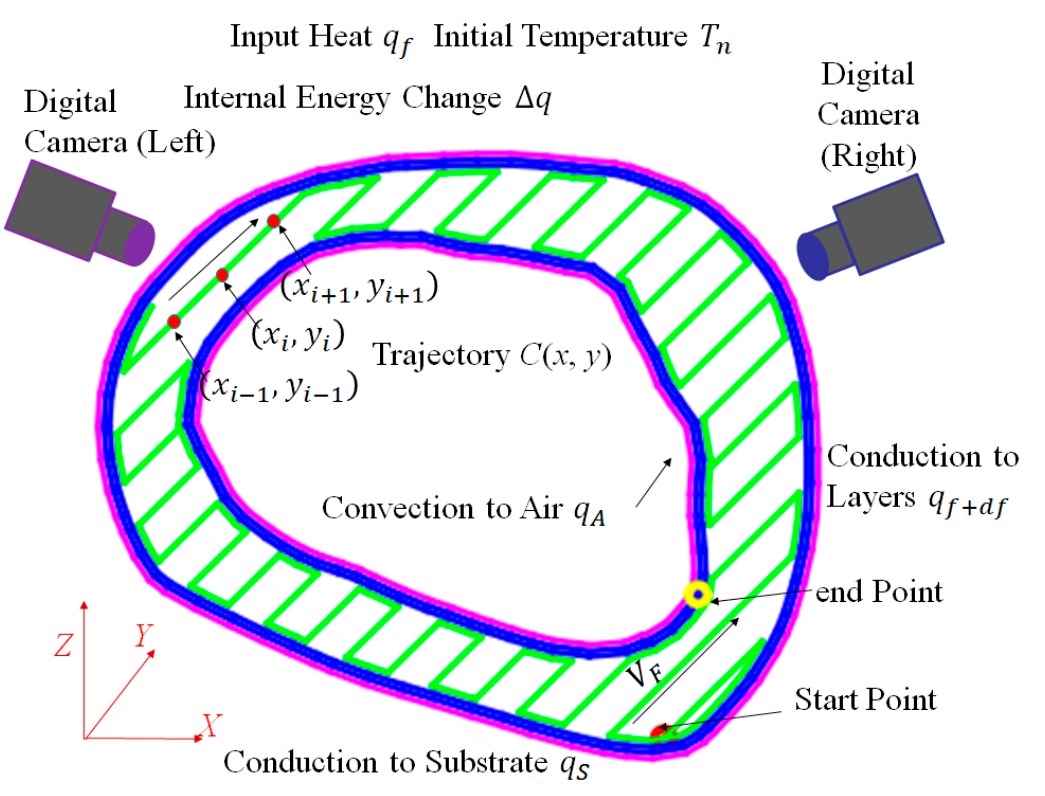
Figure 3. Schematic binocular stereo vision measurement of layered printing.